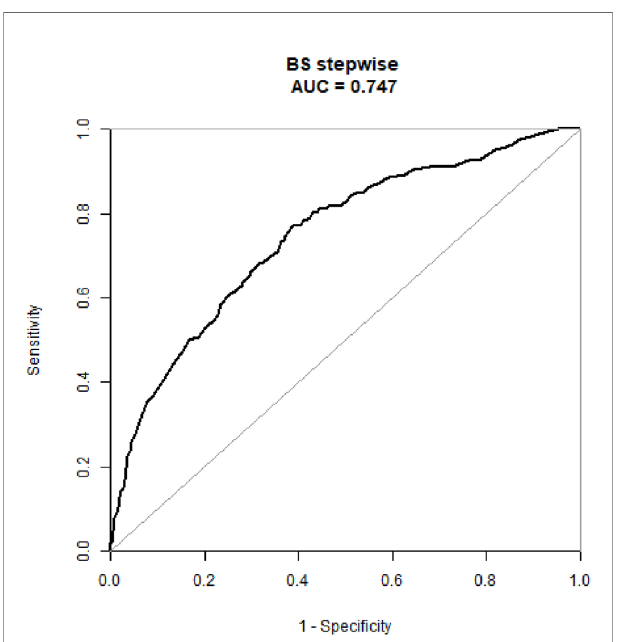
FIGURE 4 | The ROC curve of the prediction model in the N1 patients of the external validation